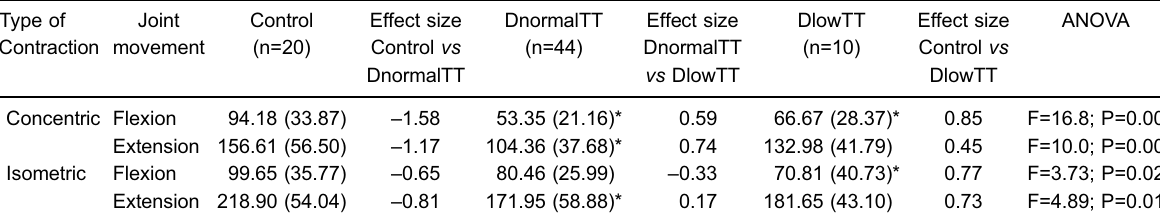
Table 2. Peak torque for the different contraction types.